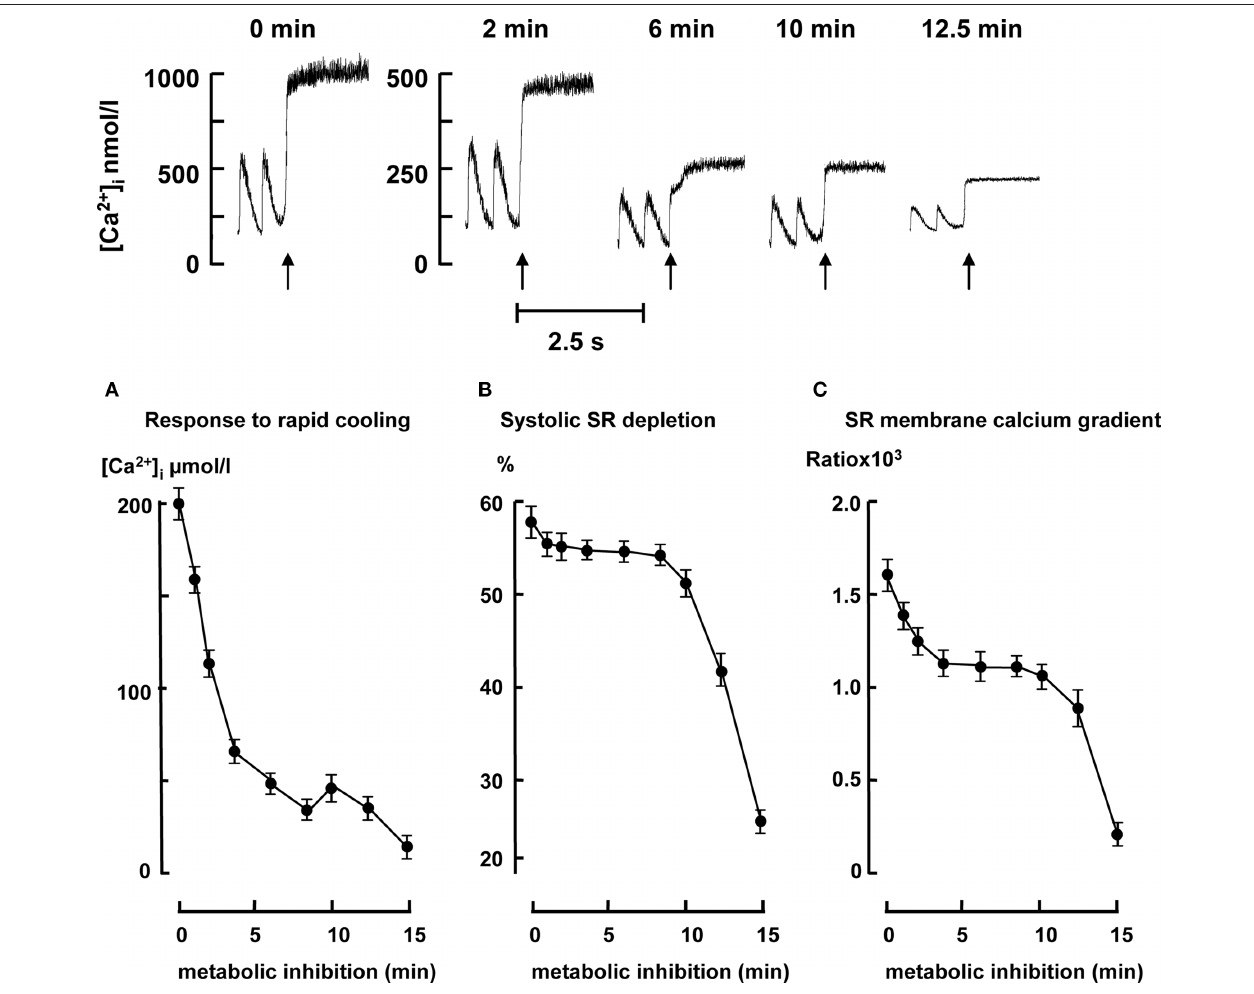
FiguRe 6 | Top panel: representative examples of the increase of [Ca 2+ ] rapid cooling (RC) in 2 Hz stimulated myocytes just before metabolic inhibition ( t = 0) and 2, 6, 10, and 12.5 min after metabolic inhibition. Bottom panel: SR calcium content, systolic SR depletion, and SR membrane calcium gradient during metabolic inhibition in 2 Hz stimulated myocytes ( n = 10 for each